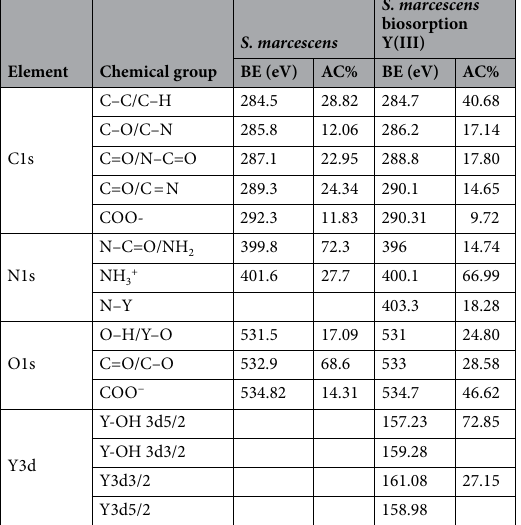
Table 5. Composition in elements (C, N, O, Y) identified, binding energy (BE) and AC (%) of the deconvolution components in the XPS spectra for S. marcescens before and after Y(III)